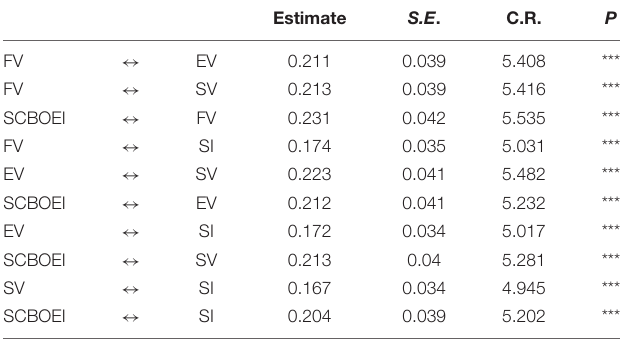
TABLE 7 | Results of the correlation analysis.